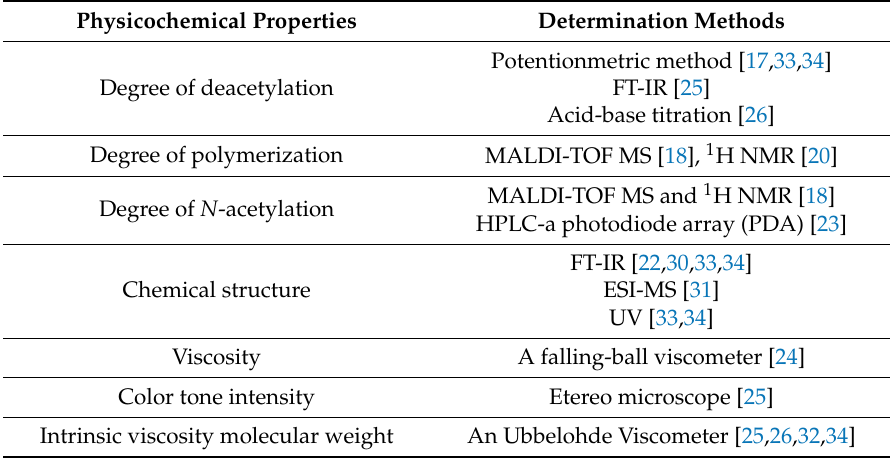
Table 2. Methods for determining the physicochemical properties of chitin, chitosan, and